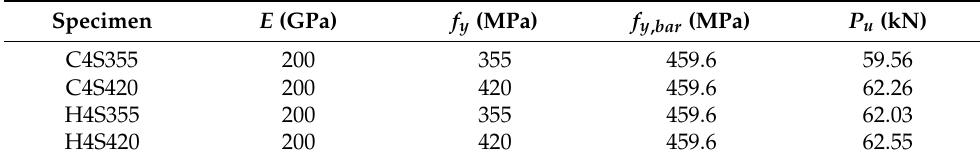
Table 10. Mechanical properties and ultimate load of the